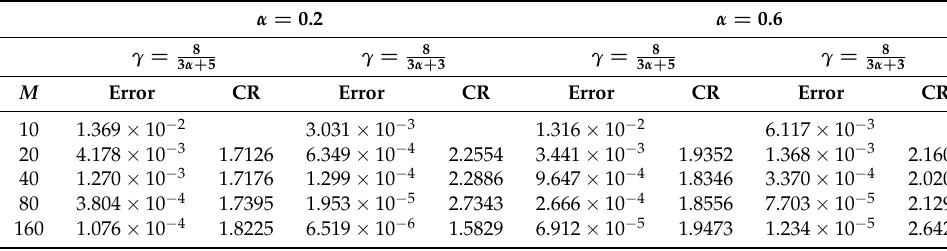
Figure 3. Plots of exact ( left ) and numerical solutions ( right ) with β = 1.4 and α = 0.2. Table 3. g ( u ) = 0 with β = 1.4.